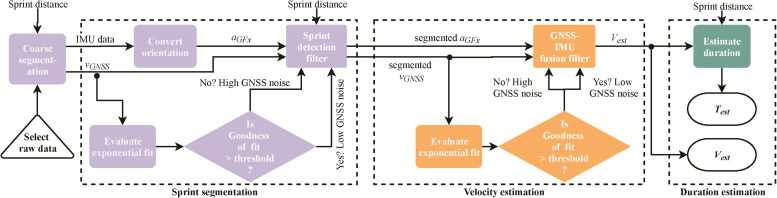
Flowchart for the sprint velocity estimation algorithm. The “coarse segmentation” block is manual and creates a window to select the approximate starting point of the relevant sprint, while remaining algorithm is automated. The “Sprint detection” and “GNSS-IMU fusion” filters are simple Kalman filters. aGFx denotes the horizontal acceleration in the global frame, vGNSS the ground velocity from the GNSS sensor, while vest and Test represent the estimated velocity and sprint duration, respectively.